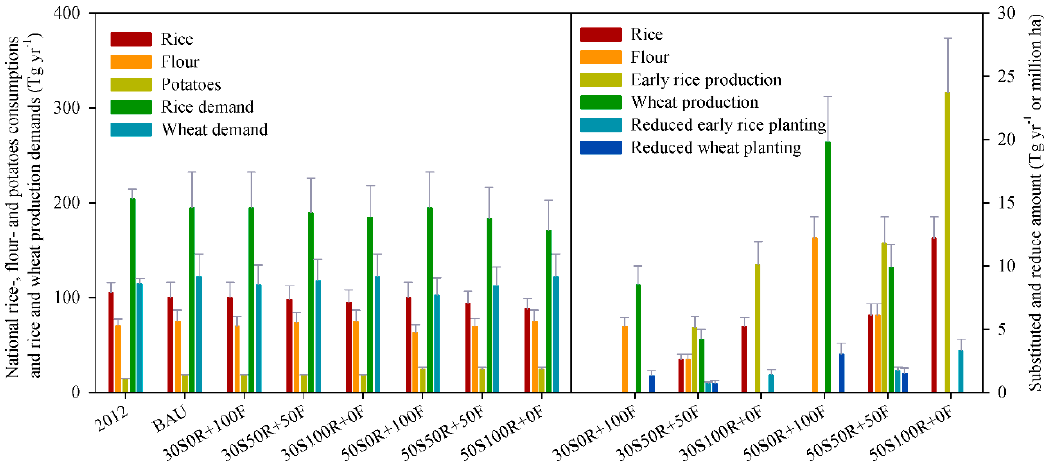
Figure 2. National rice-, flour- and potato consumptions; rice and wheat production demands (Tg yr -1 ; left); potatoes as staple foods substituted for rice and flour, and rice and wheat production (Tg yr -1 ); reduced early rice and wheat planting (million ha) under the different substitution scenarios in 2020, in comparison with 2012 (right).